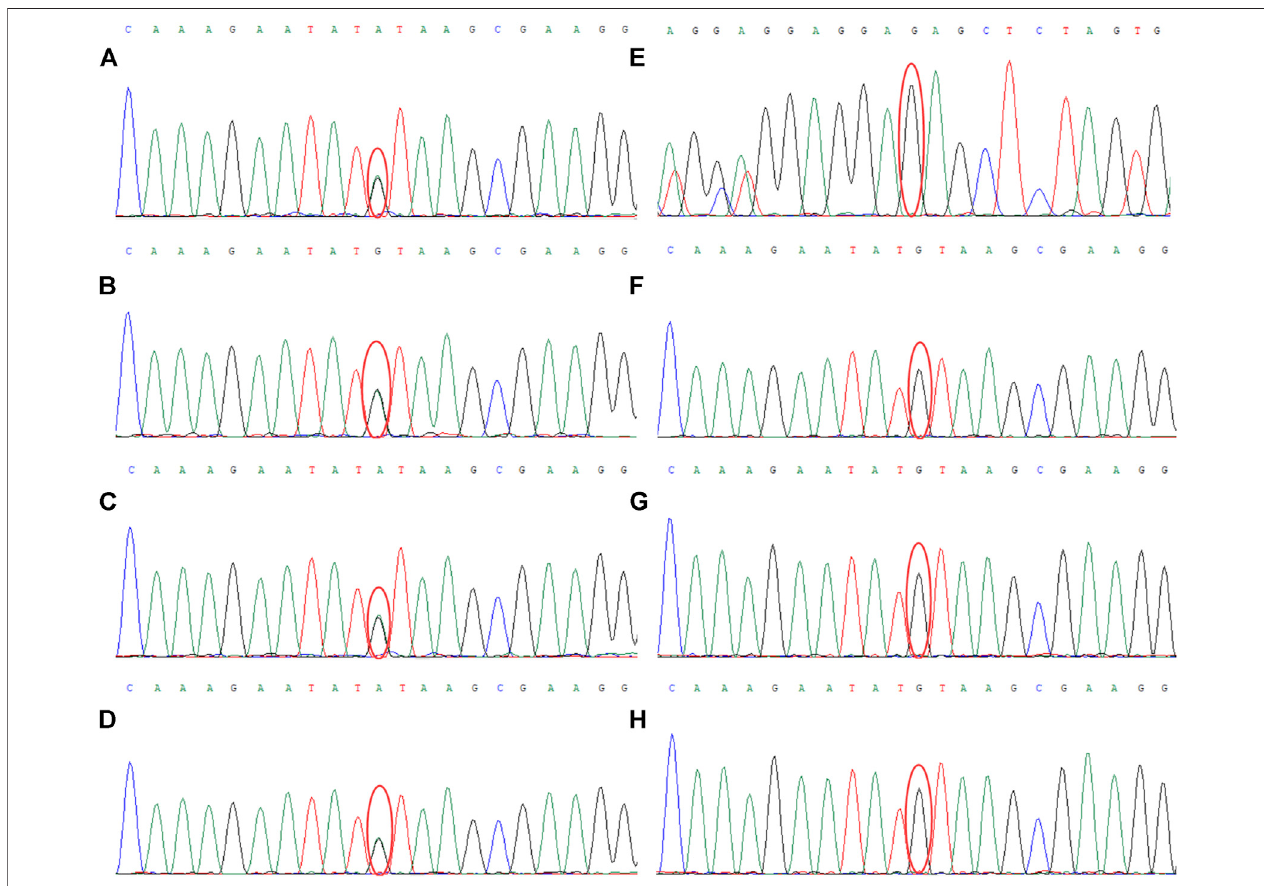
FIGURE3| Sangersequencingchromatogramof CSF1R genemutationanalysisofsevenfamilymembersinthe fi rstfamily.Sequencingchromatogramsidenti fi ed a novel heterozygous mutation in the CSF1R gene on chromosome 5q32: one is a splicing mutation (c.2654+1G > A) in intron 20 of CSF1R in the proband (A) , patient Ⅲ -10 (B) ,patient Ⅲ -11 (C) ,andpatient Ⅳ -5 (D) ,and theotherisanindelmutationinexon22(c.2833_2835delGAG)of CSF1R (E) .Nomutationofthe CSF1R genecan be found in patient Ⅱ -8 (F) , patient Ⅳ -1 (G) , and patient Ⅳ -2 (H) .